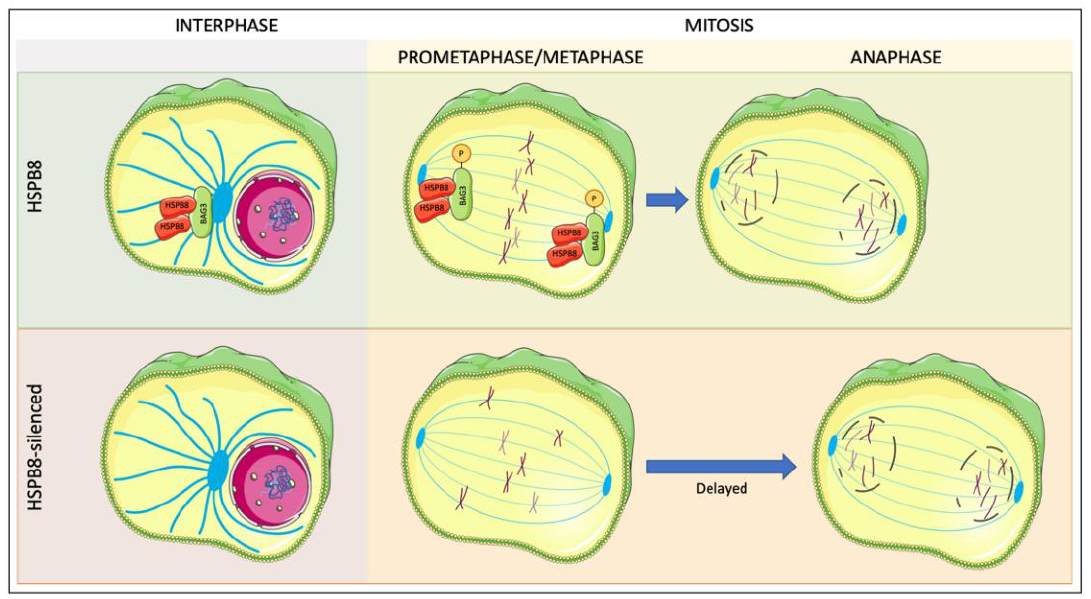
Figure 3. HSPB8 and BAG3 play an important role in mitosis. Before nuclear envelope breakdown, HSPB8 and BAG3 localize together at centrosome. With the beginning of prometaphase and the nuclear disassembly, BAG3 becomes hyperphosphorylated, and at the metaphase to anaphase transition, it re-localizes at the spindle poles participating in the formation of the correct mitotic spindle orientation. BAG3 behavior is closely dependent on HSPB8, and a reduction in BAG3 hyperphosphorylation occurs in HSPB8-silenced mitotic cells. BAG3 silencing increases the number of cells arrested at prometaphase, or at metaphase with unaligned chromosomes at the spindle poles. HSPB8 silencing also causes a delay and an alteration in cytokinesis. This figure was created using Servier Medical Art templates, which are licensed under a Creative Commons Attribution 3.0 Unported License; https://smart.servier.com (accessed on 27 January